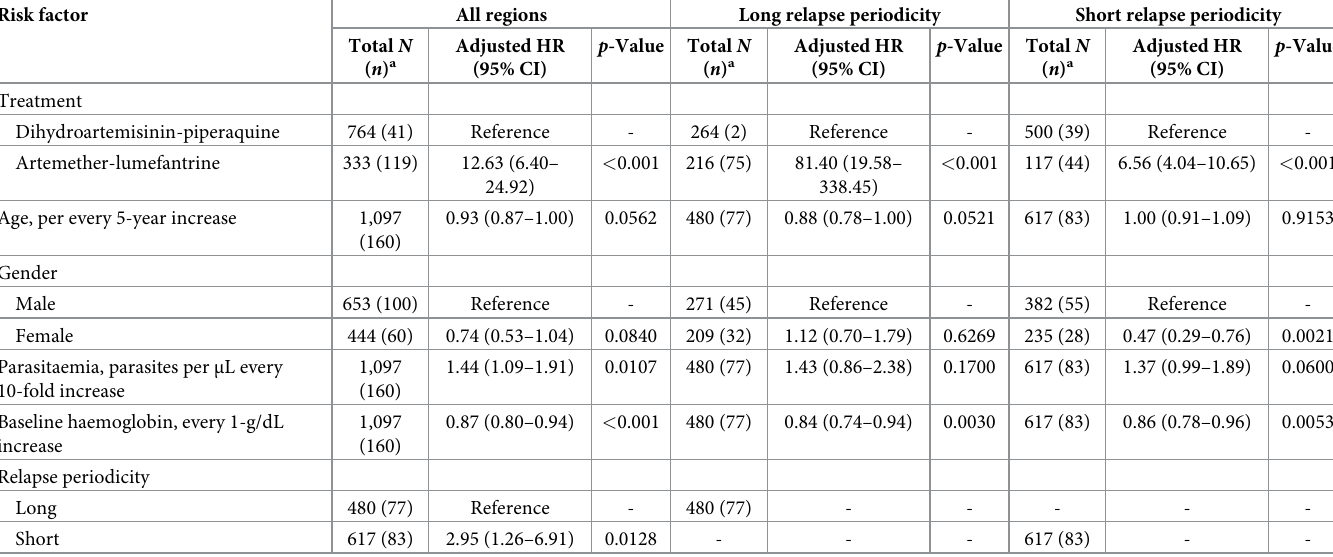
Table 4. Multivariable model for rate of P . vivax recurrence between days 7 and 42 in patients receiving artemether-lumefantrine or dihydroartemisinin-pipera- quine alone.